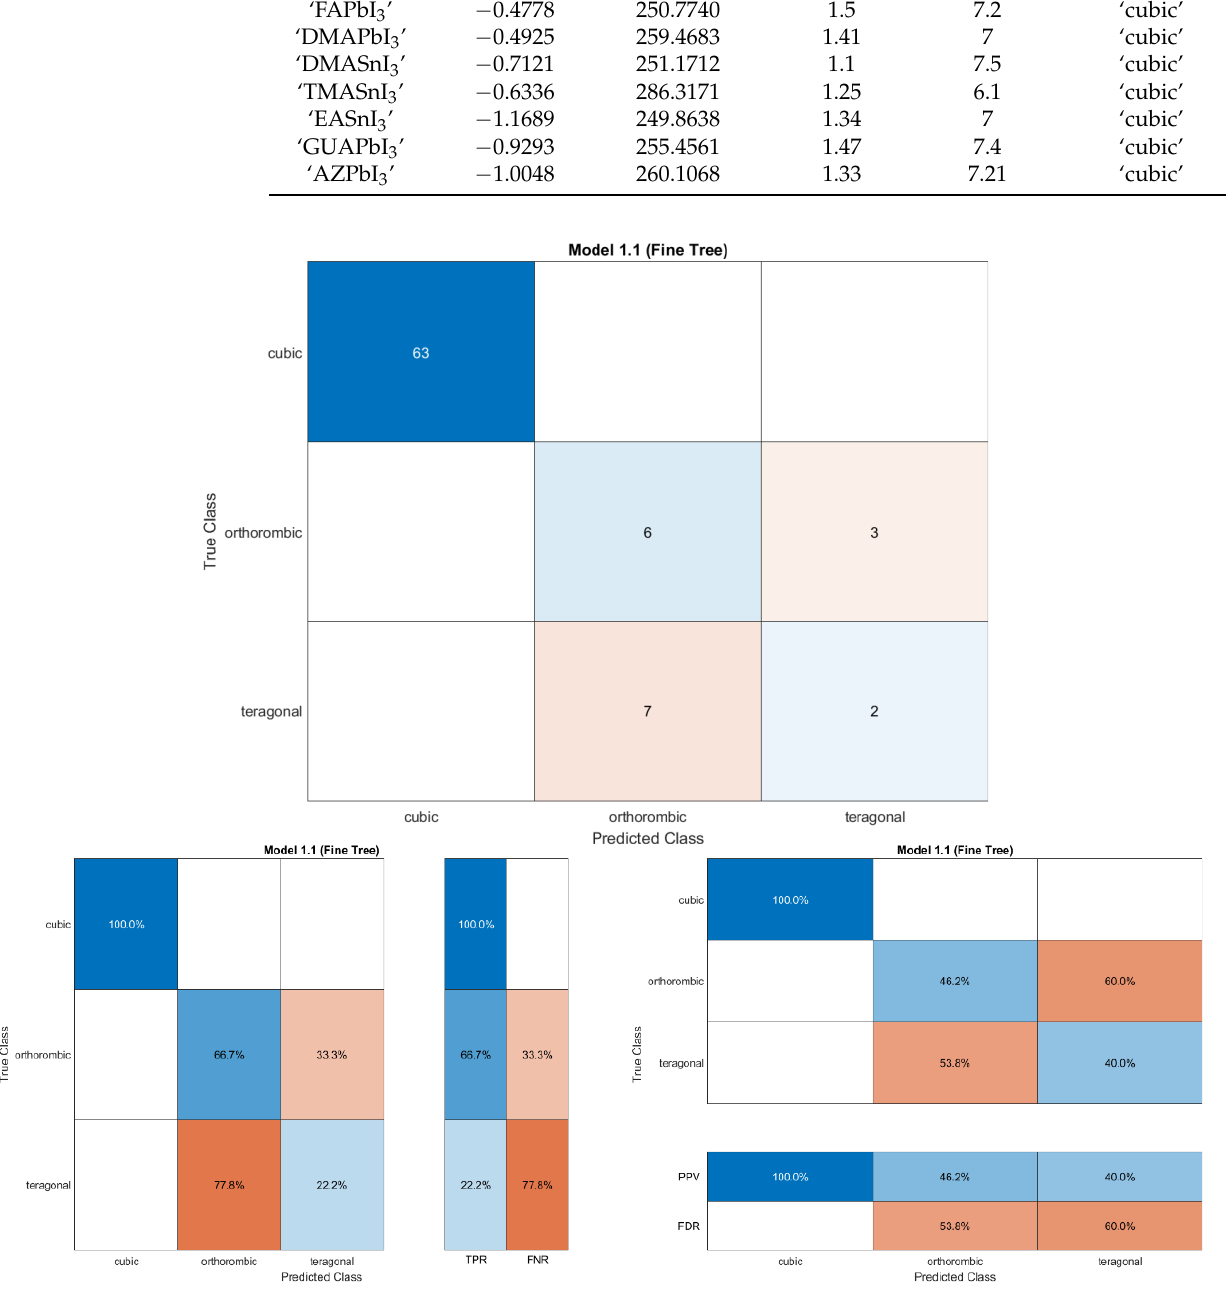
Figure 7. The confusion matrix, TPR and FNR matrix, and PPV and FDR matrix.